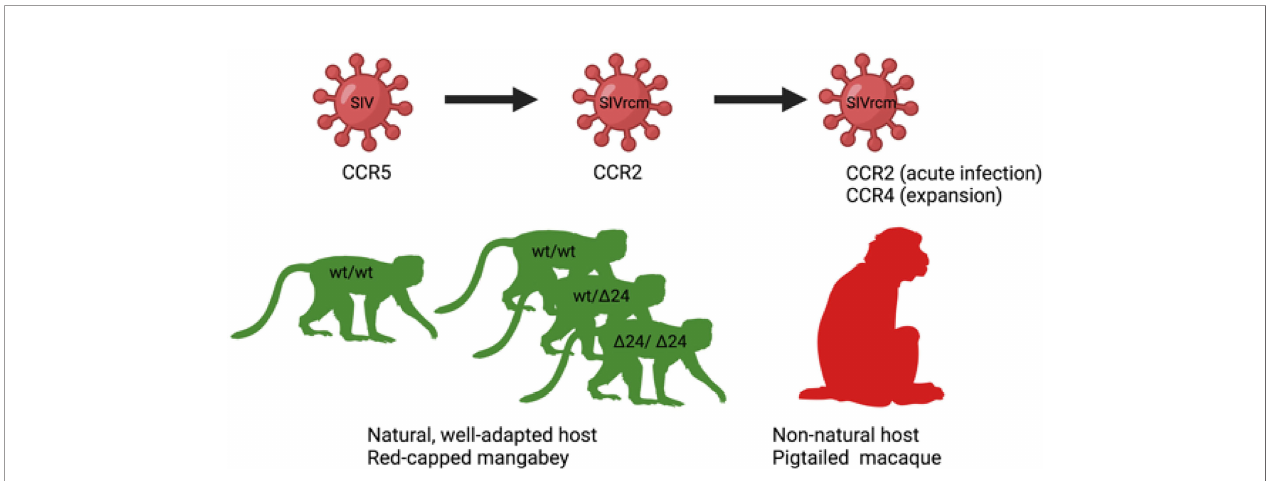
FIGURE 2 | Host-pathogen co-adaptations in a natural (left) and non-natural host (right). On the left, a putative origin of a unique among SIVs CCR2-tropic SIVrcm infecting red-capped mangabey RCM: A high frequency of CCR5- D 24 mutation, disrupting CCR5 function and protecting from infection with CCR5-tropic SIV, led to the virus adaptation via changing the usage of CCR5 to CCR2b for cell entry (60). On the right, SIVrcm adaptation of coreceptor usage to a new host: experimental SIVrcm infection of pigtailed macaque, a natural host, showed a CCR2 usage in early infection and expansion of coreceptor usage to CCR4 demonstrating that lentiviral adaptation may occur rapidly through strain selection